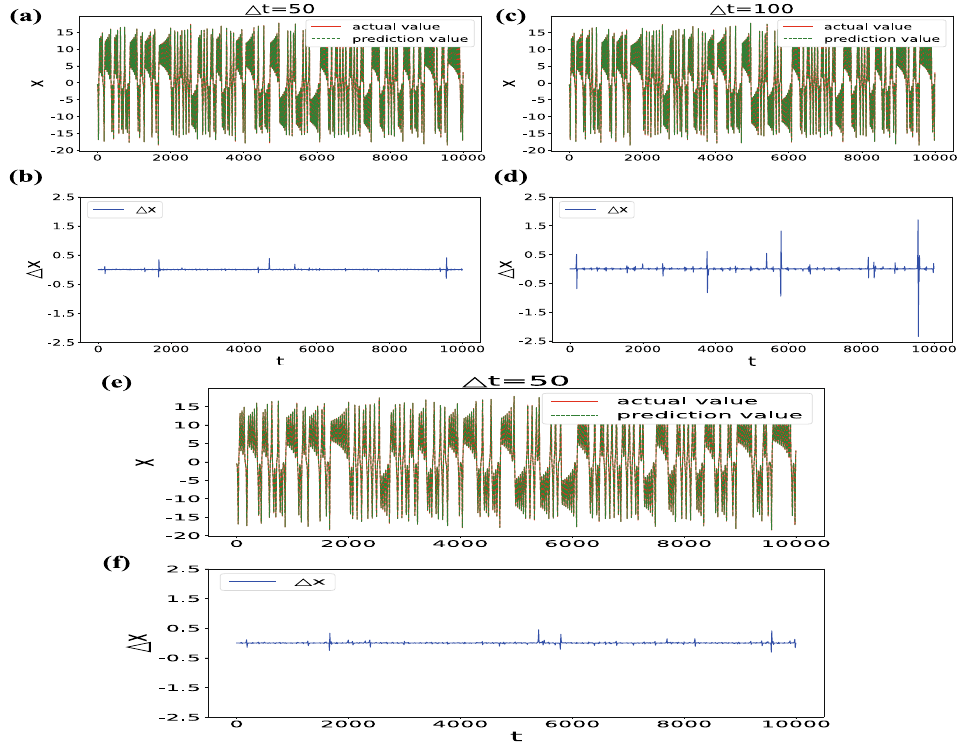
Figure 7. The sequence diagram shows the reconstruction results of the reconstructed variables and the difference between the reconstructed values and the actual values ( (cid:31) t = 50, 100, respectively). ( a , c ) The comparison between the actual variable x (red solid line) and the corresponding reconstruction results (green dashed line), for the yz − x mode. ( b , d ) The sequence diagrams of (cid:31) x under the yz − x mode. The (cid:31) x maintains less than 0.5 in ( b ), the (cid:31) x in ( d ) is always small except in several cases. ( e , f ) The sequence diagram of the reconstruction results and the difference (cid:31) x , corresponding to the reconstructed variable x ( (cid:31) t = 50, the y − xz mode). In ( f ), the difference (cid:31) x is basically around (cid:31) x = 0